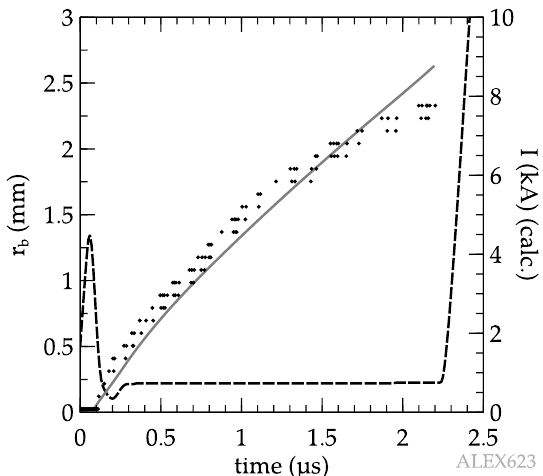
Figure 5. Radial expansion of the metallic neutral gas ( experimental values, calculated) and calculated current values ( ) for a charging voltage of 18 kV. Radial expansion resolution is ± 0.1 mm. Notice the low values in the current